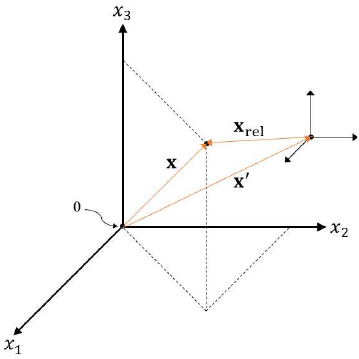
Figure 1. Vector x is represented as x rel in the relative coordinate system x (cid:48)